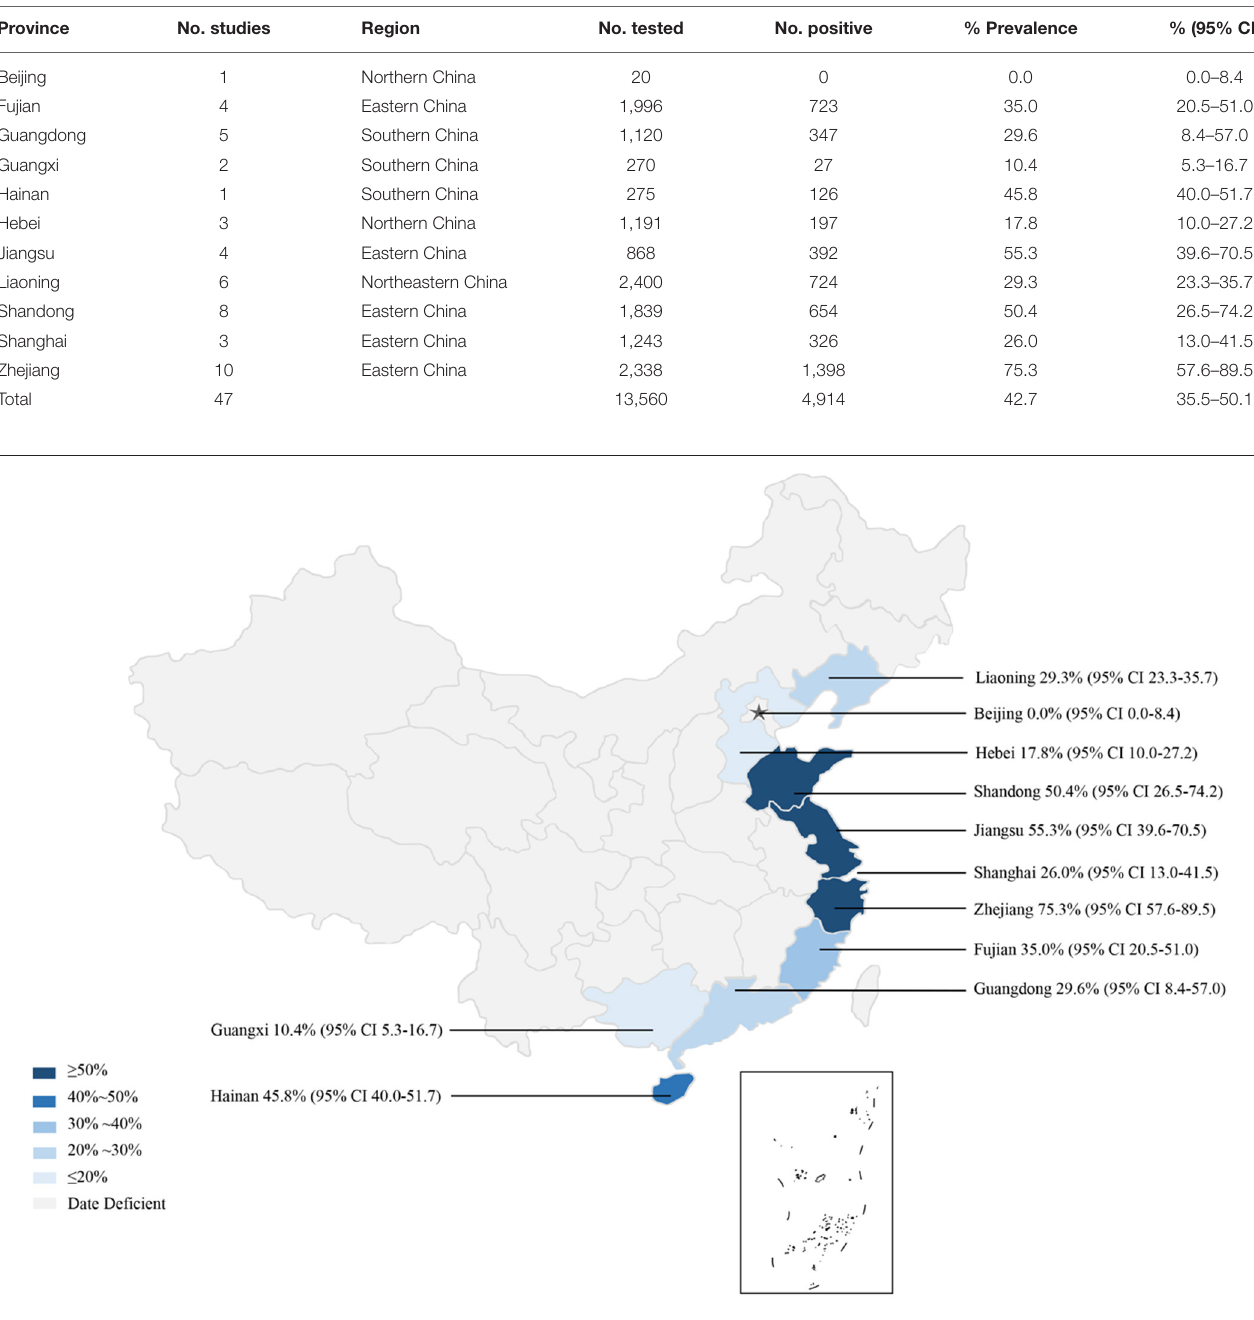
FIGURE 3 | Map of anisakid infection in fish amongst studies conducted in